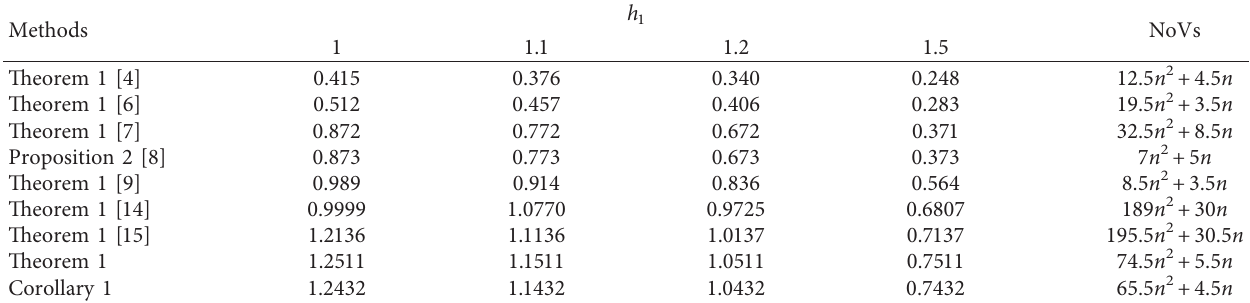
Table 2: The calculated upper bounds of d